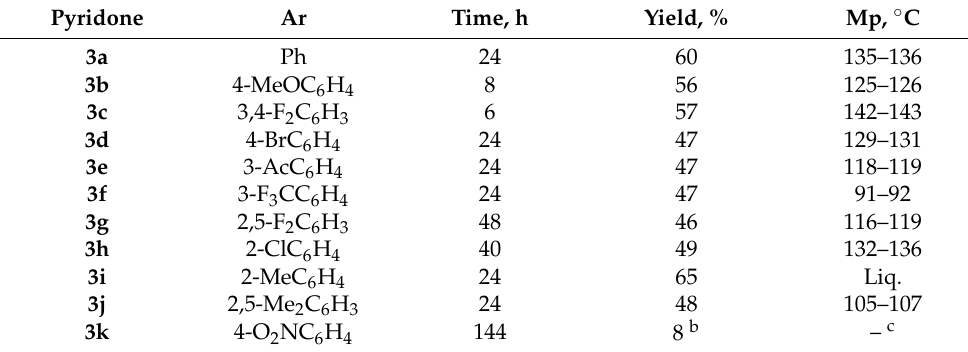
Table 2. The scope of 4-pyridone synthesis from DHA- f 6 a .